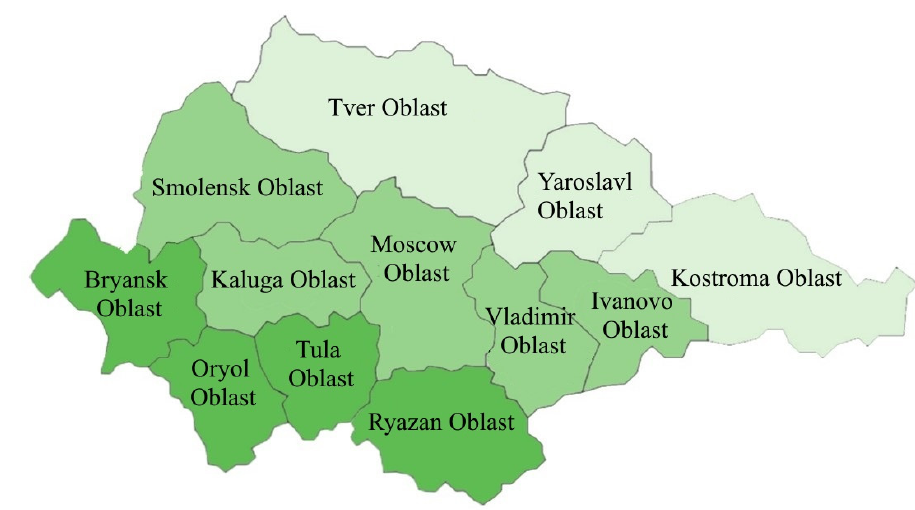
Figure 1. Agro-climatic subzones in the Central region of the Non-Chernozem zone. The classification was based on the temperature climatic factors—the average temperature for the growing season and the sum of active temperatures for the vegetation. Along with the temperatures, the total precipitation and the HTC value for the growing season were analyzed (Table 1). Table 1. Characteristics of the agro-climatic subzones of the Central region of Russian Non- Chernozem zone